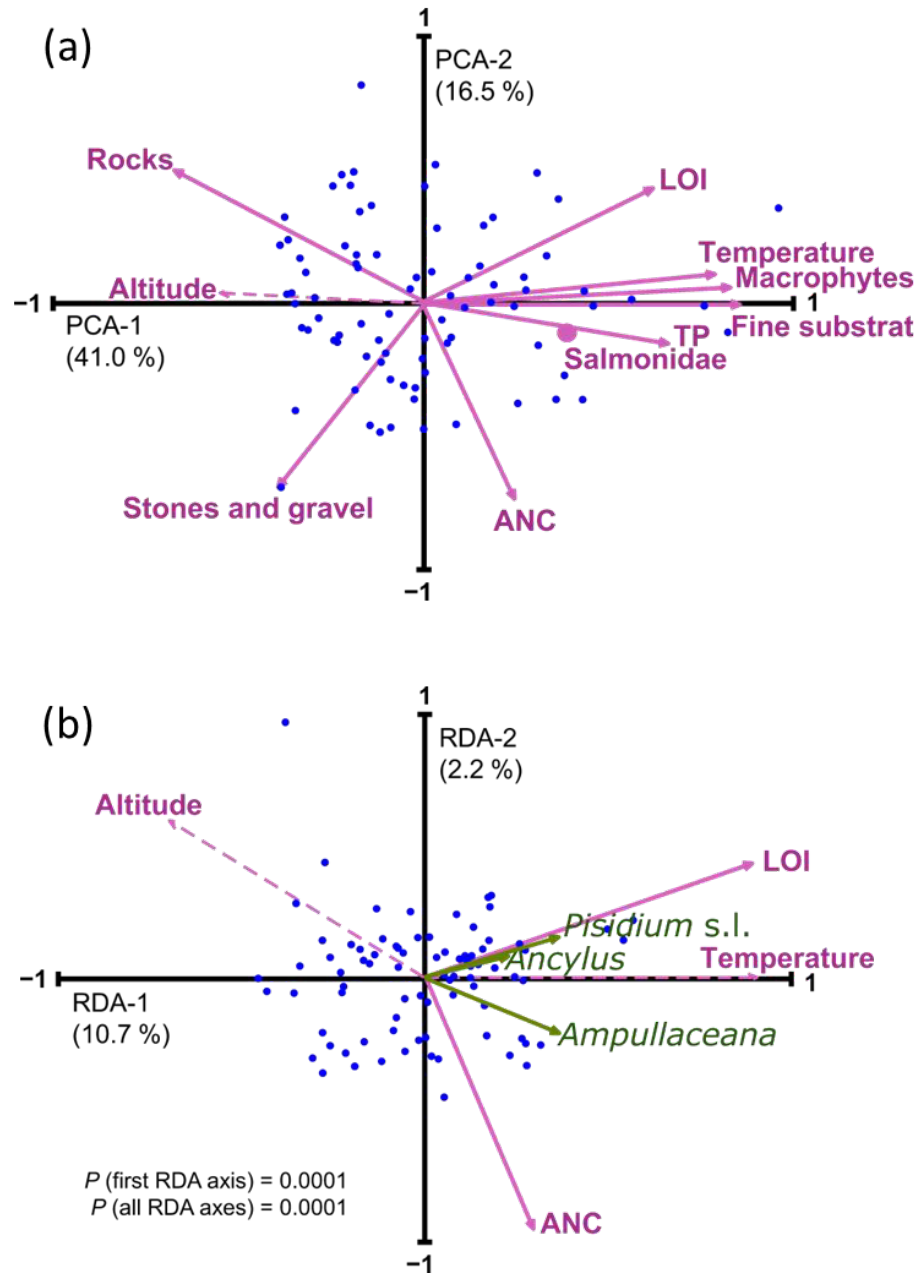
Figure 4. ( a ) Principal component analysis (PCA) of the environmental variables considered in the study. ( b ) Redundancy analysis (RDA) of mollusks distribution (green arrows) with a forward selection of environmental variables. Dashed lines indicate passive variables included in the ordination for comparison with the forward-selected variables. Salmonidae was a nominal variable and, therefore, is indicated as a dot in the biplot.